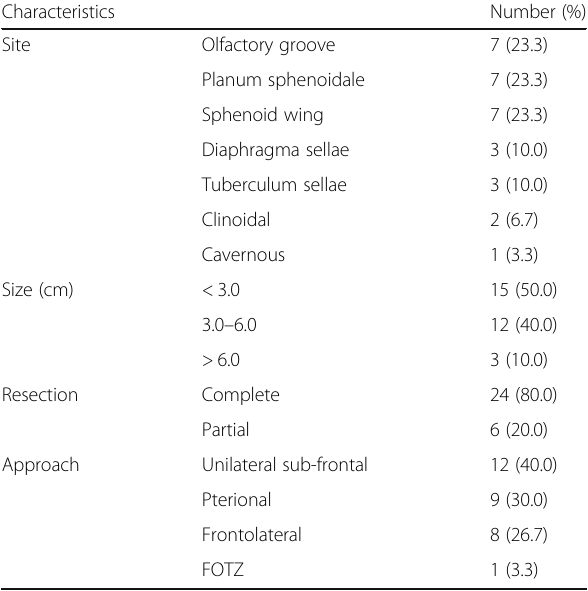
Table 2 Pathological characteristics of studied